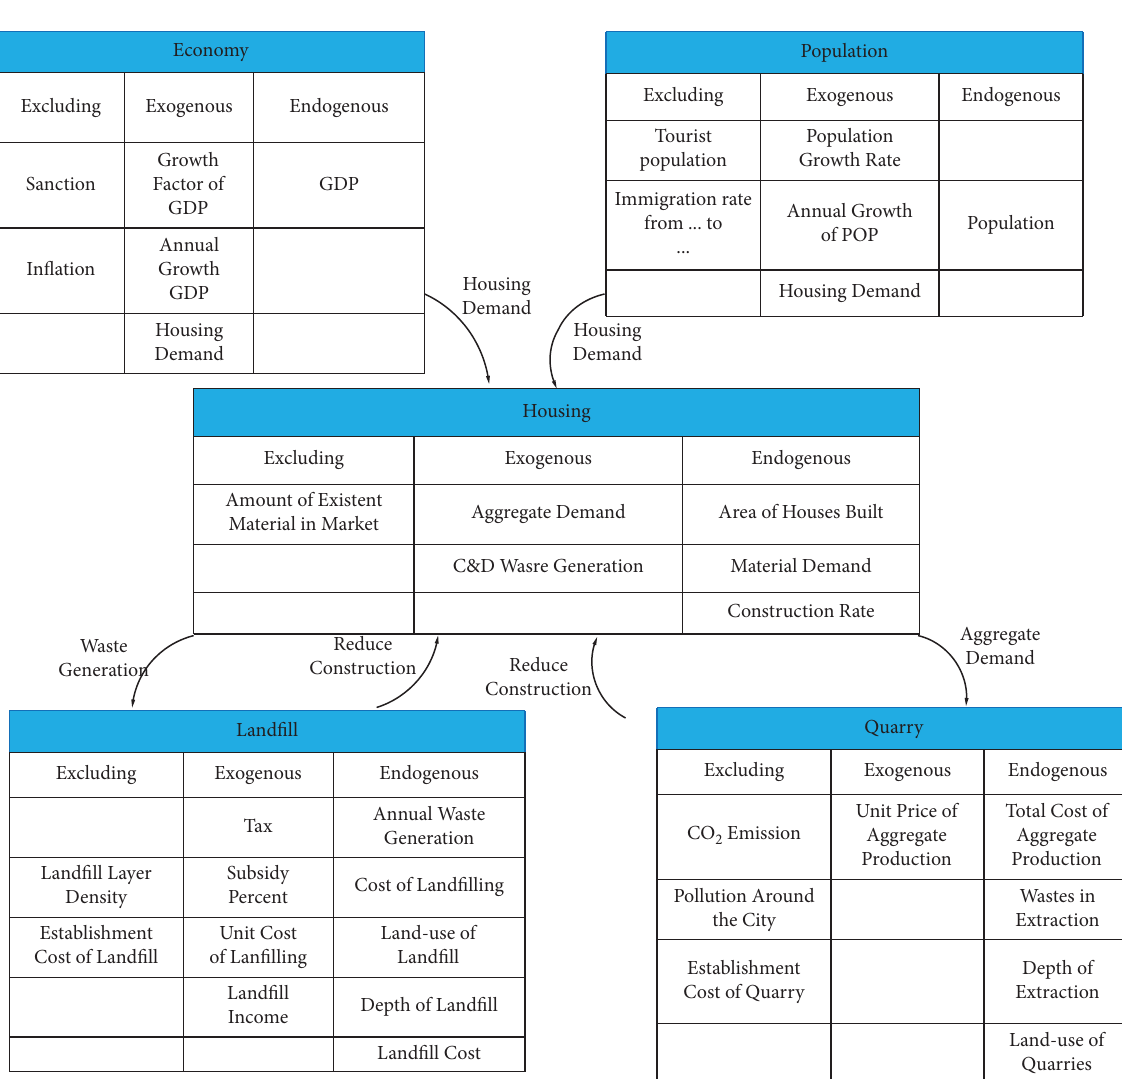
Figure 1: Chart of the subsystems of the C&D waste